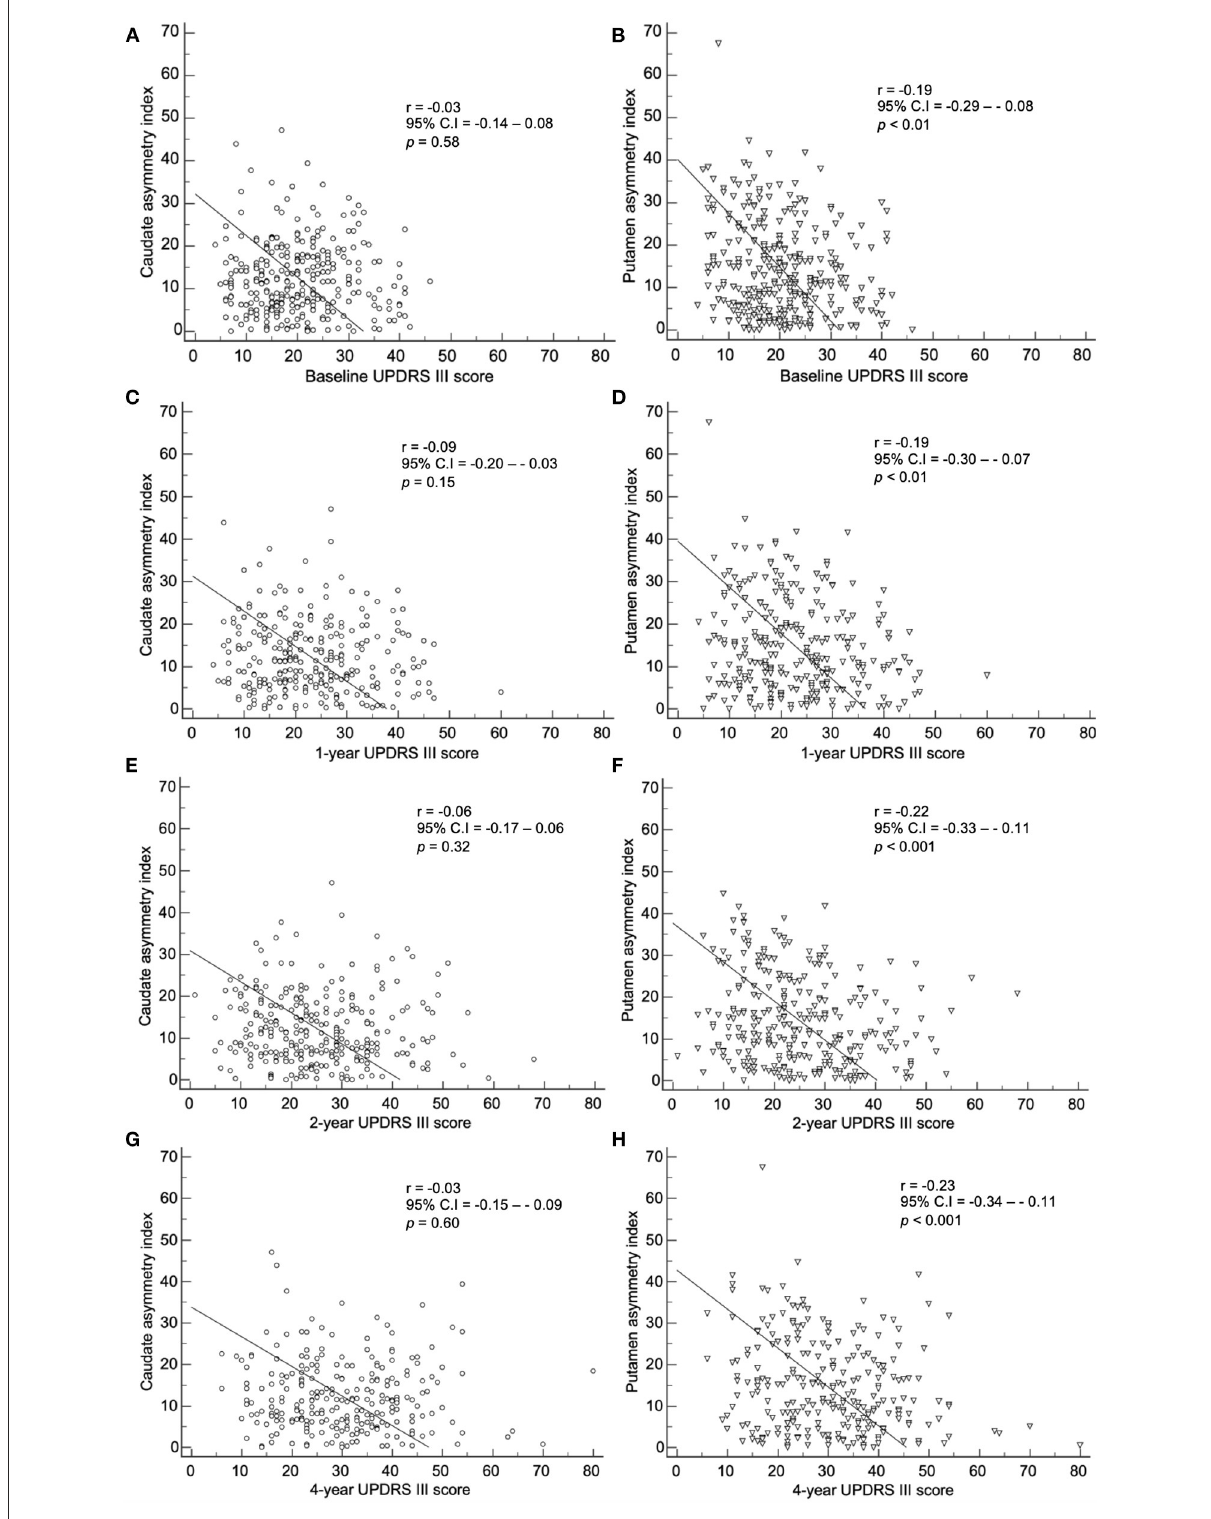
FIGURE6 Correlation of the baseline asymmetry index of the caudate by method 2 with (A) baseline, (C) 1-year, (E) 2-year, and (G) 4-year UPDRS III scores. Correlation of the baseline asymmetry index of the putamen by method 2 with (B) baseline, (D) 1-year, (F) 2-year, and (H) 4-year UPDRS III